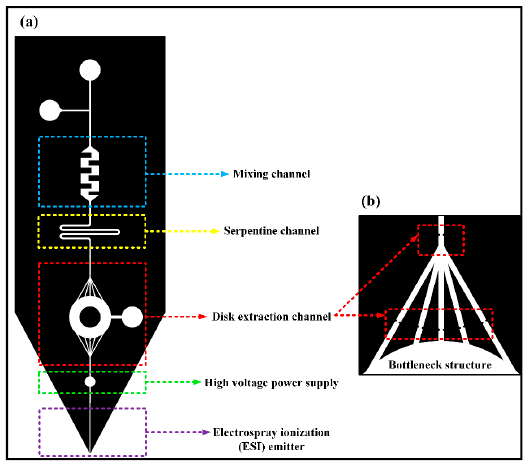
Figure 1. ( a ) Design of the chip structure; ( b ) bottleneck structure.